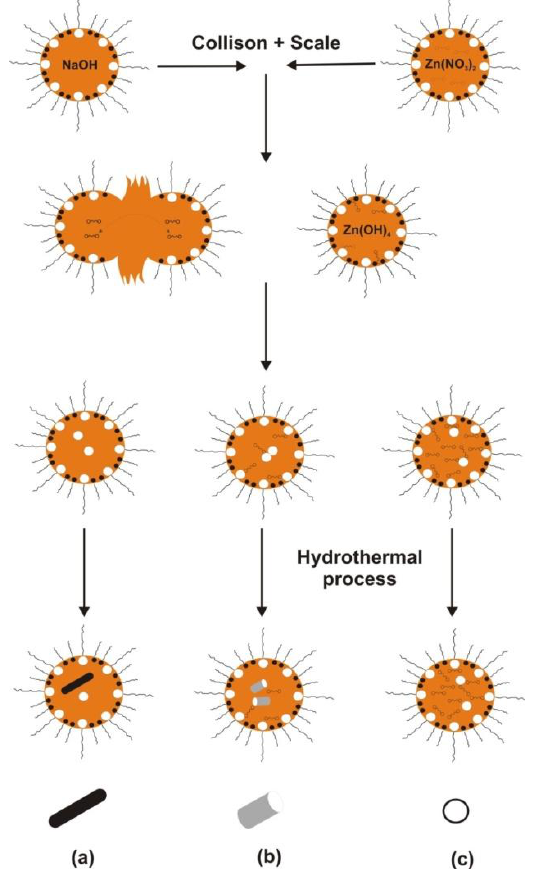
Figure 5. Synthesis and morphology of crystalline ZnO synthesized in a